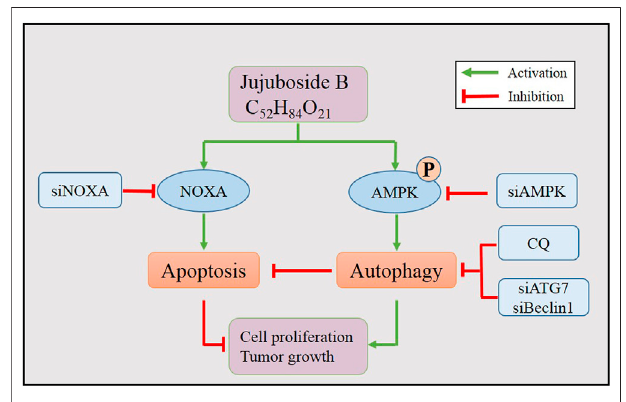
FIGURE 7 | Working model of JB-induced apoptosis and